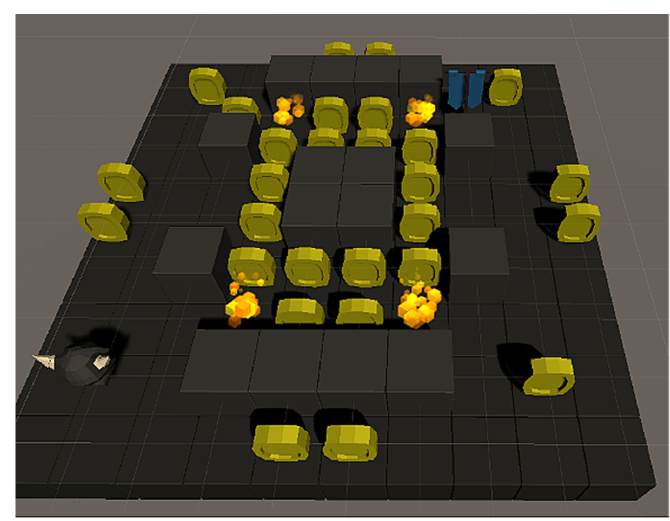
Appl. Sci. 2022 , 11 , x FOR PEER REVIEW Figure 10. Semi-symmetric results. Figure 10. Semi-symmetric results.